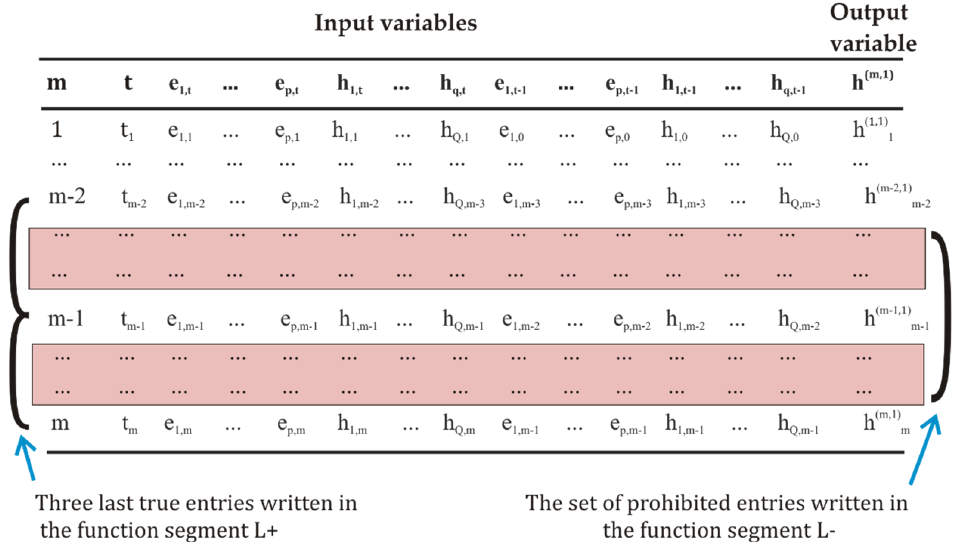
Figure 6. Formation of the part prohibited for modifications of the truth table, corresponding to the segment L-, which is complementary to the true segment